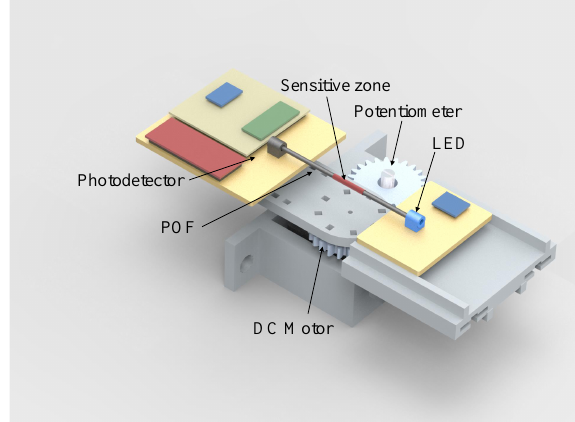
Figure 5. Experimental setup for POF curvature sensor